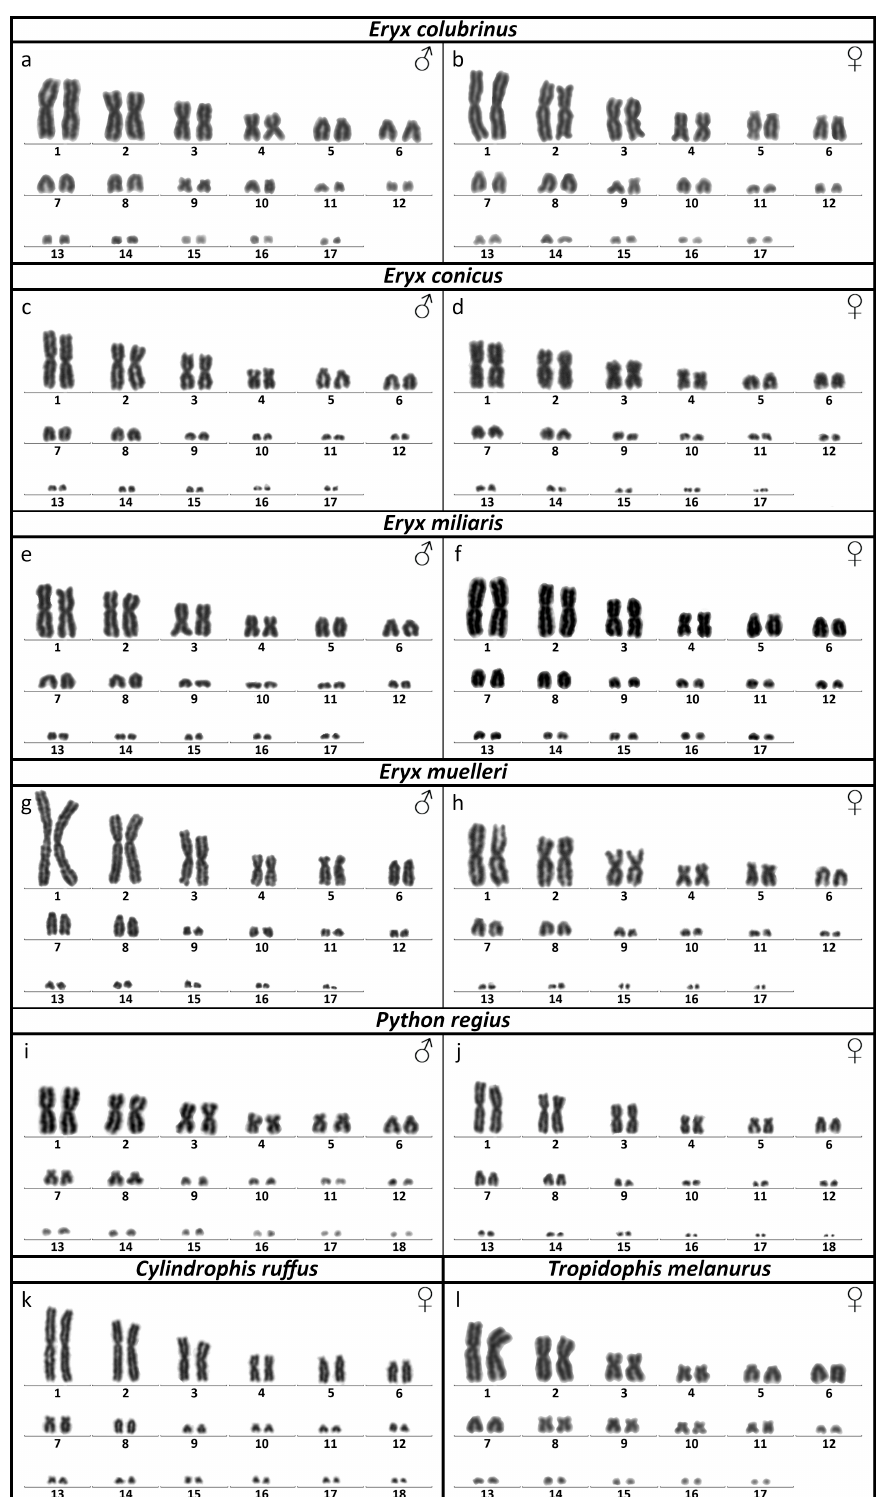
Figure 1. Giemsa-stained karyograms are depicted for the species: ( a , b ) Eryx colubrinus , ( c , d ) Eryx conicus , ( e , f ) Eryx miliaris , ( g , h ) Eryx muelleri , ( i , j ) Python regius , ( k ) Cylindrophis ruffus , and ( l ) Tropidophis melanurus . Sex is indicated.